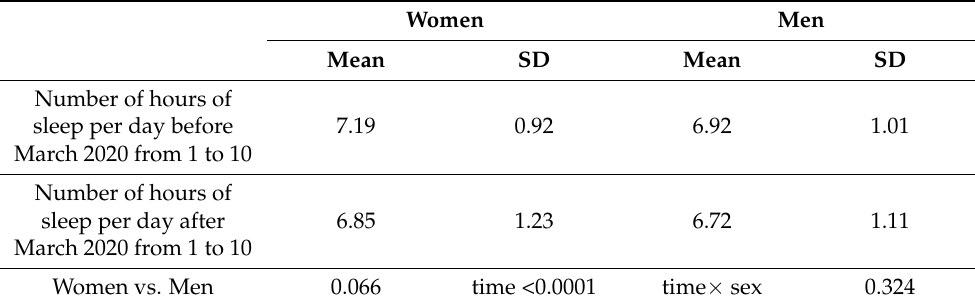
Table 3. Sleep timespan before and during the pandemic.